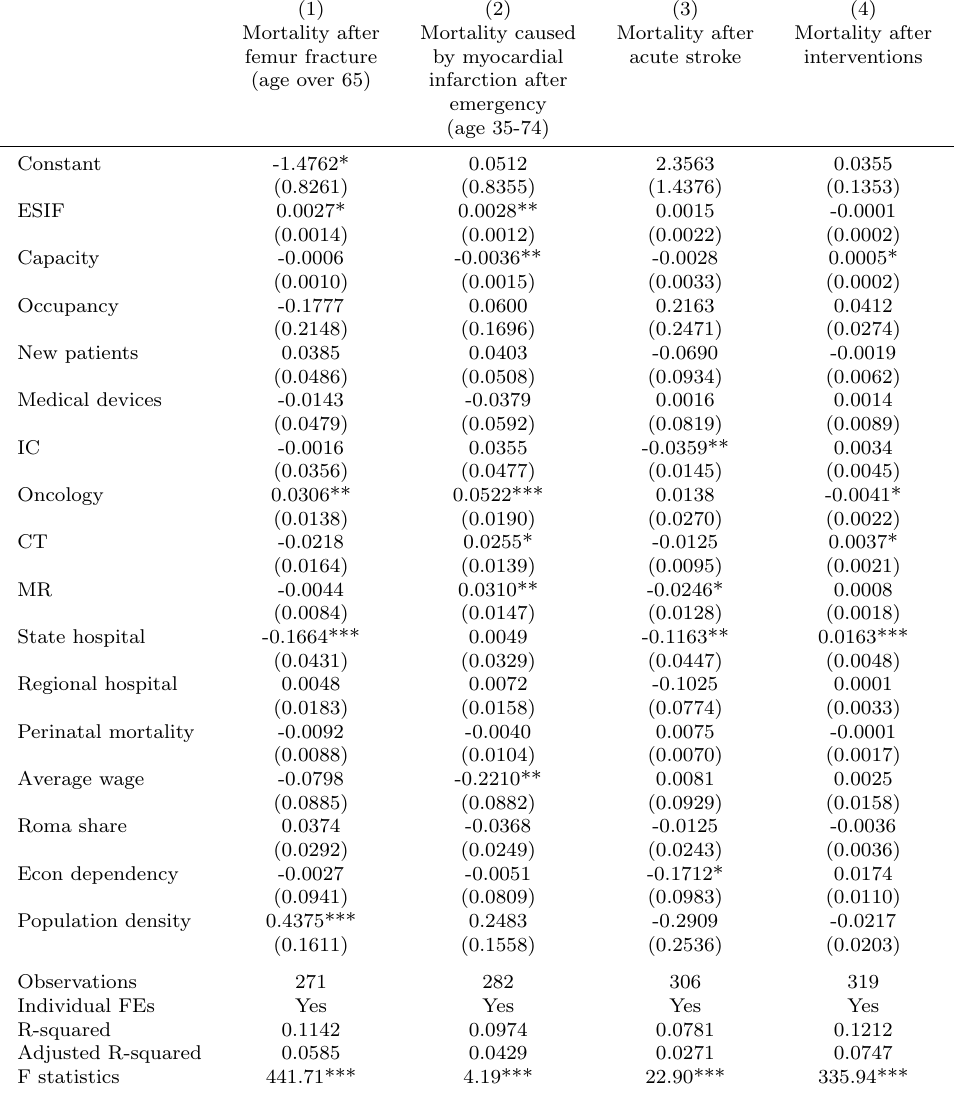
Table A.4: Contemporaneous effect of cumulative ESIF on the mortality rate in selected categories – full model (part